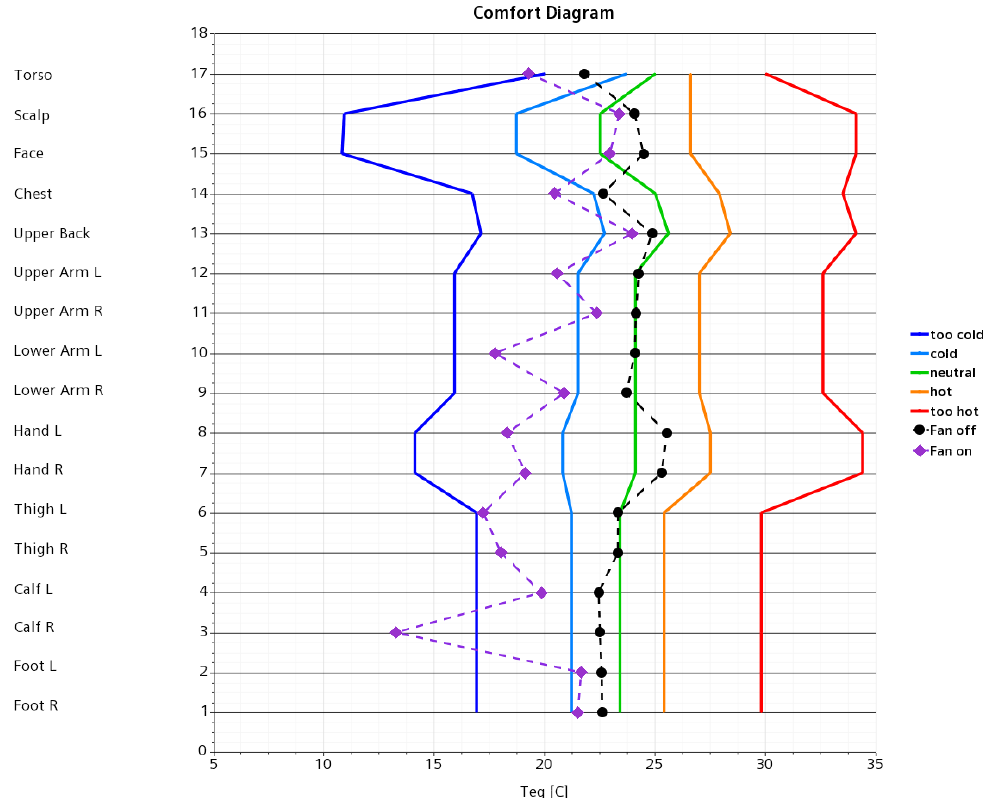
Figure 19. Comfort diagram with T eq values for the chamber with and without fan. Dashed lines for better visibility only. Fan off Fan on